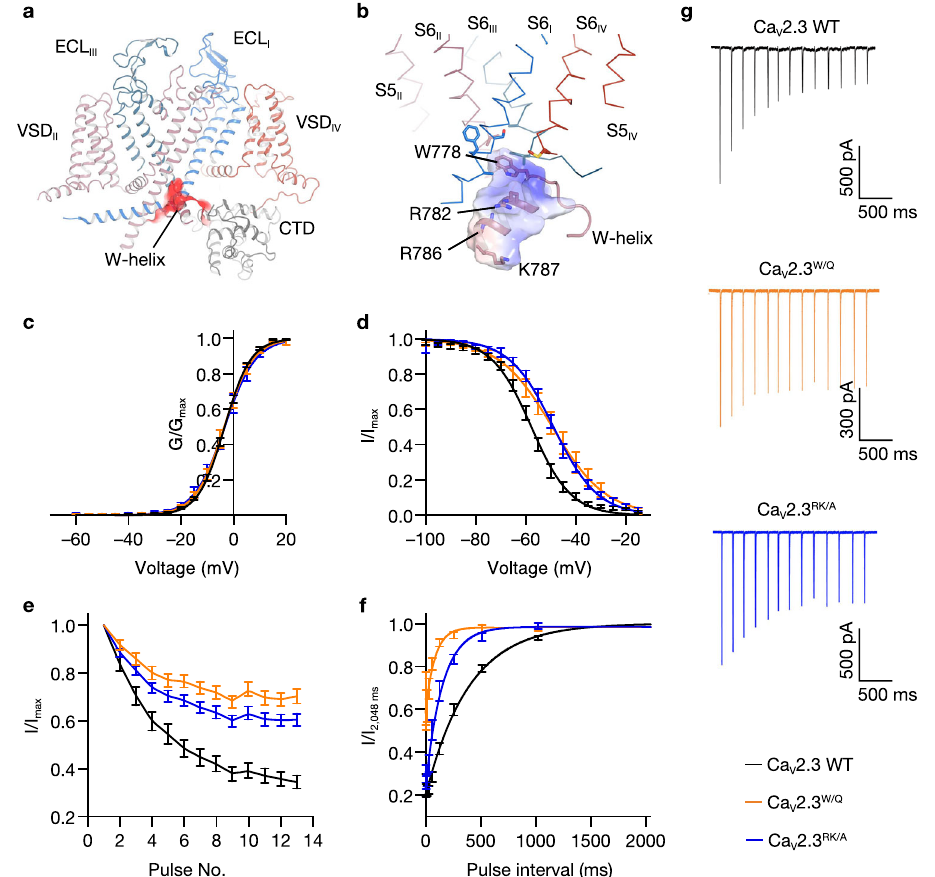
fi rst spike. Ca Δ w-helix , n =9; Ca V 2.3 WT, n =13; Ca V 2.3 W/Q , n =15; V 2.3 RK/A , n =14. Δ w-helix , n =6; Ca V 2.3 W/Q , n =6; V 2.3 RK/A , n =7. g Representative current respon- V 2.3WT,black;Ca V 2.3 W/Q , orange; Ca V 2.3 RK/A , blue. Data are presented as mean±SEM. n biological independent